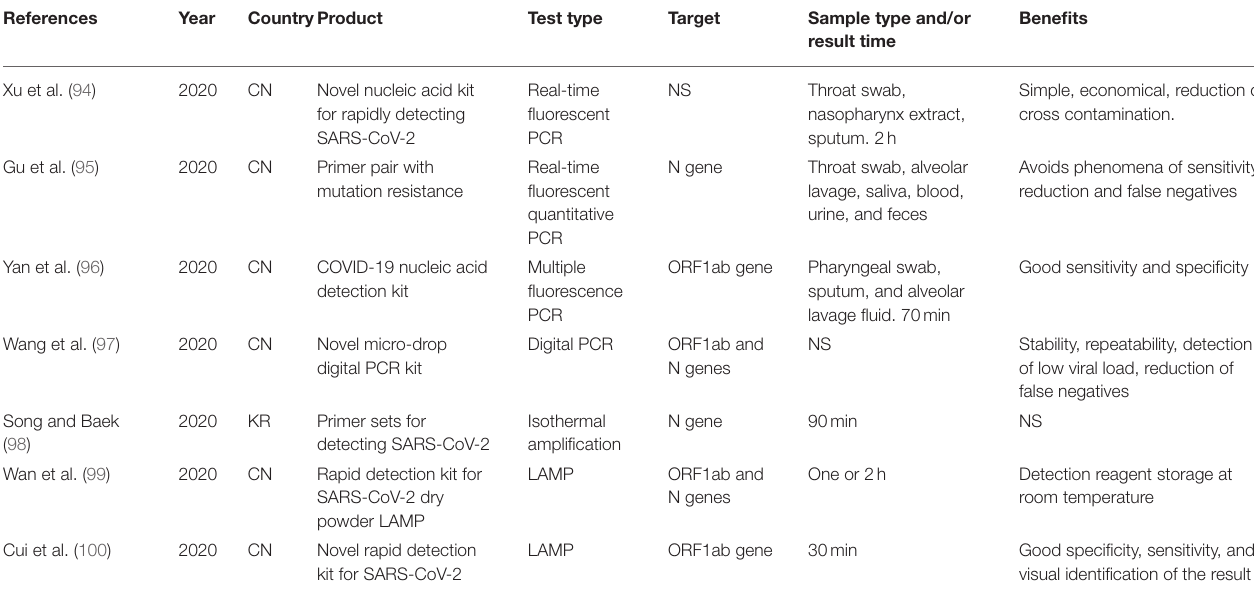
TABLE 2 | Published patents of SARS-CoV-2 (COVID-19)